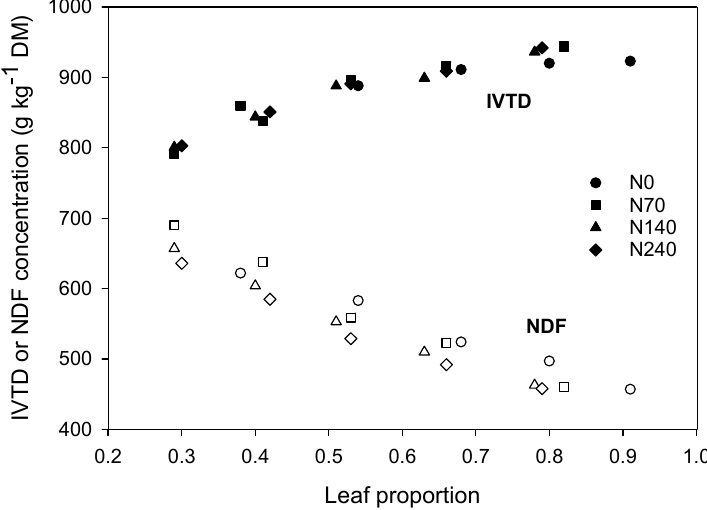
Figure 7. Relationship between forage digestibility (IVTD) or neutral detergent fiber (NDF) concentration with the proportion of leaves in the forage mass (W L /W) of timothy during spring growth under four N fertilization rates. Data obtained at Fredericton (45.55° N; 66.36° W; Canada) and redrawn from Bélanger and McQueen [32]. N0, 0 kg N ha − 1 ; N70, 70 kg N ha − 1 ; N140, 140 kg N ha − 1 ; N240, kg N ha − 1 .